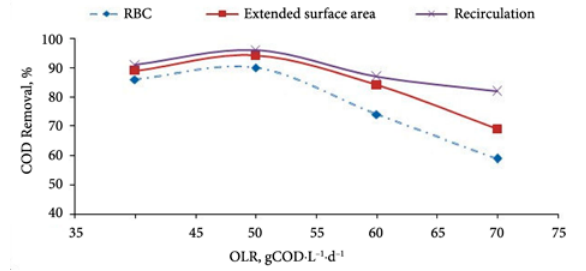
Fig. 6. COD removal with various OLR in RBC, with extended surface and recirculation at HRT of 24